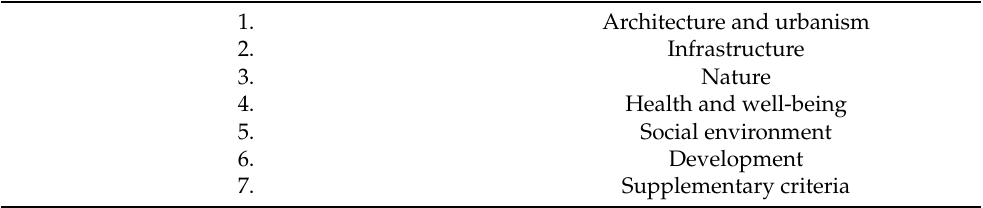
Table 3. Criteria classification domains: authors proposal.